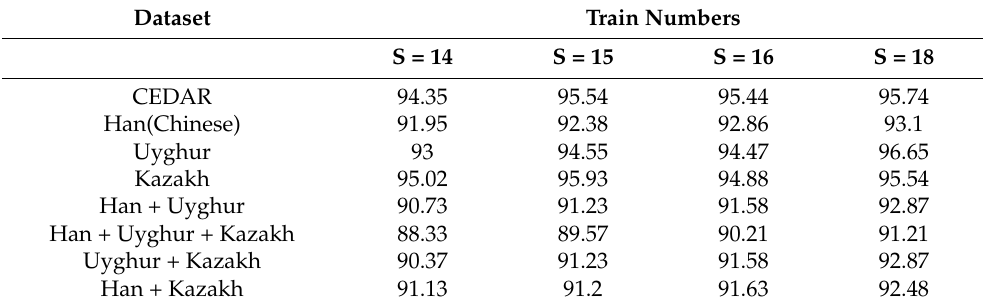
Table 5. Used the RF classifier to identify the result after the fusion of the two features.